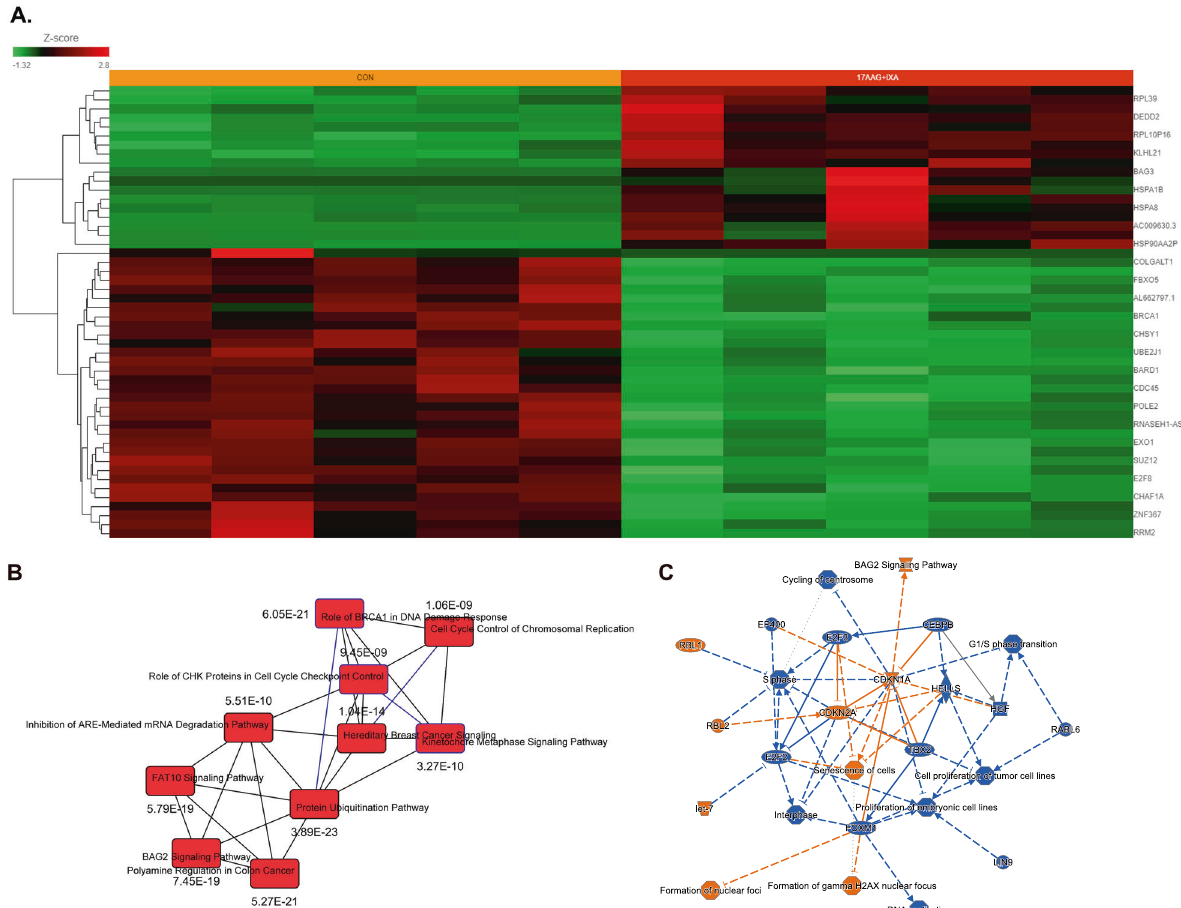
Fig. 7 Differential gene expression analysis of 17-AAG + PI combination treatment. A Heatmaps generated using unsupervised hierarchical clustering (HC) analysis showing top differentially expressed genes (bulk RNAseq data) that showed signi fi cant de-regulation, 24 h following 17-AAG + Ixazomib combination treatment. IPA analysis results show B top 10 canonical pathways and C graphical summary. Columns represent cell lines, and rows represent genes. Prior to Hierarchical clustering, gene expression values were z -score